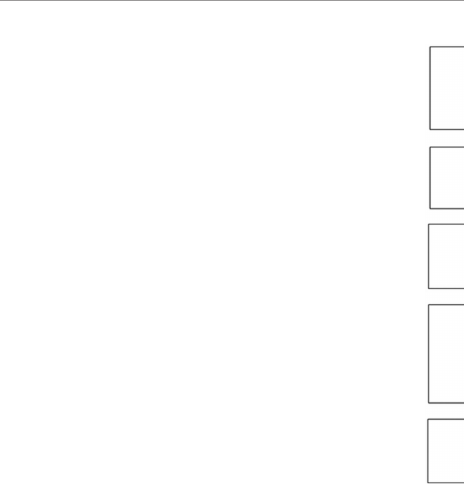
FIGURE 1 | Study design. To develop classi fi ers for the early diagnosis of breast cancer, the work fl ow of our study consists of three stages, including the discovery stage, training, and validation stage. In the discovery stage, we used whole-genome sequencing to identify circRNAs with signi fi cantly different levels. In the training stage, we developed classi fi ers with three regression models by using the circRNAs levels detected by qPCR. In the validation stage, the predictive ef fi cacy of the classi fi ers was validated. qPCR, quantitative real-time polymerase chain reaction. circRNA, circular